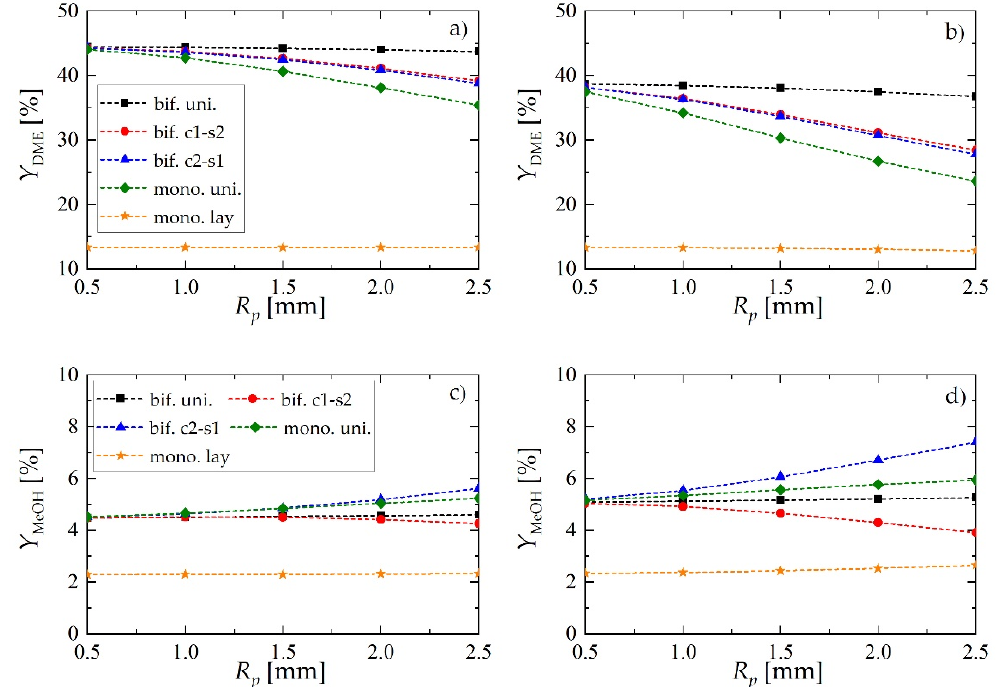
Figure 6. Yield of dimethyl ether and methanol obtained using different reactor- and pellet-level structuring of catalytic active sites: ( a ) yield of DME for u in = 0.05 m · s − 1 ; ( b ) yield of DME for u in = 0.1 m · s − 1 ; ( c ) yield of MeOH for u in = 0.05 m · s − 1 ; ( d ) yield of MeOH for u in = 0.1 m · s − 1 .